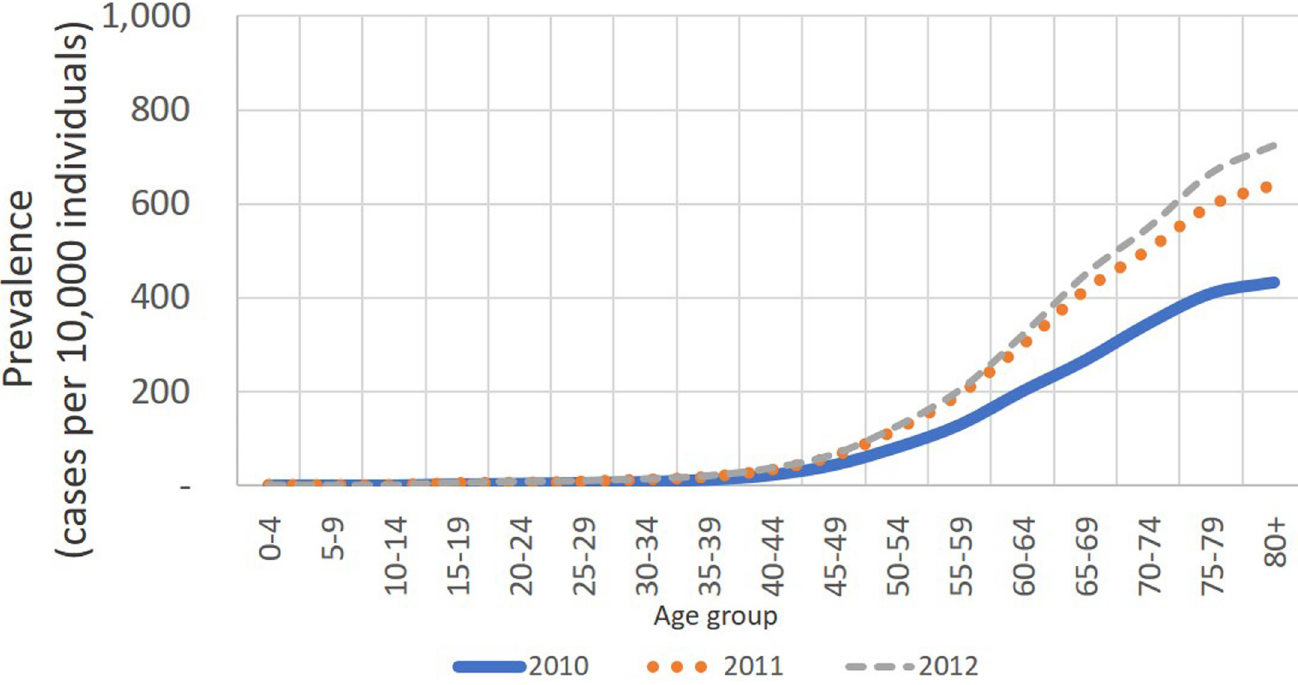
Fig 2. Distribution of CHD prevalence by age and year.